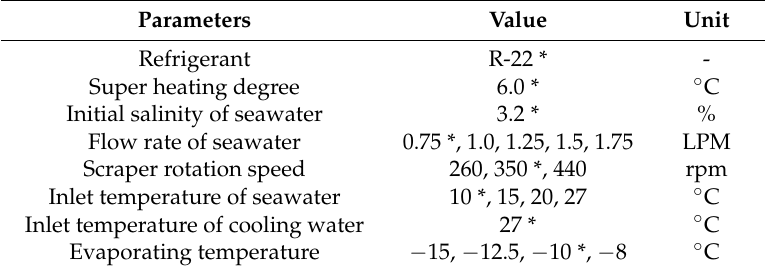
Table 3. Experimental